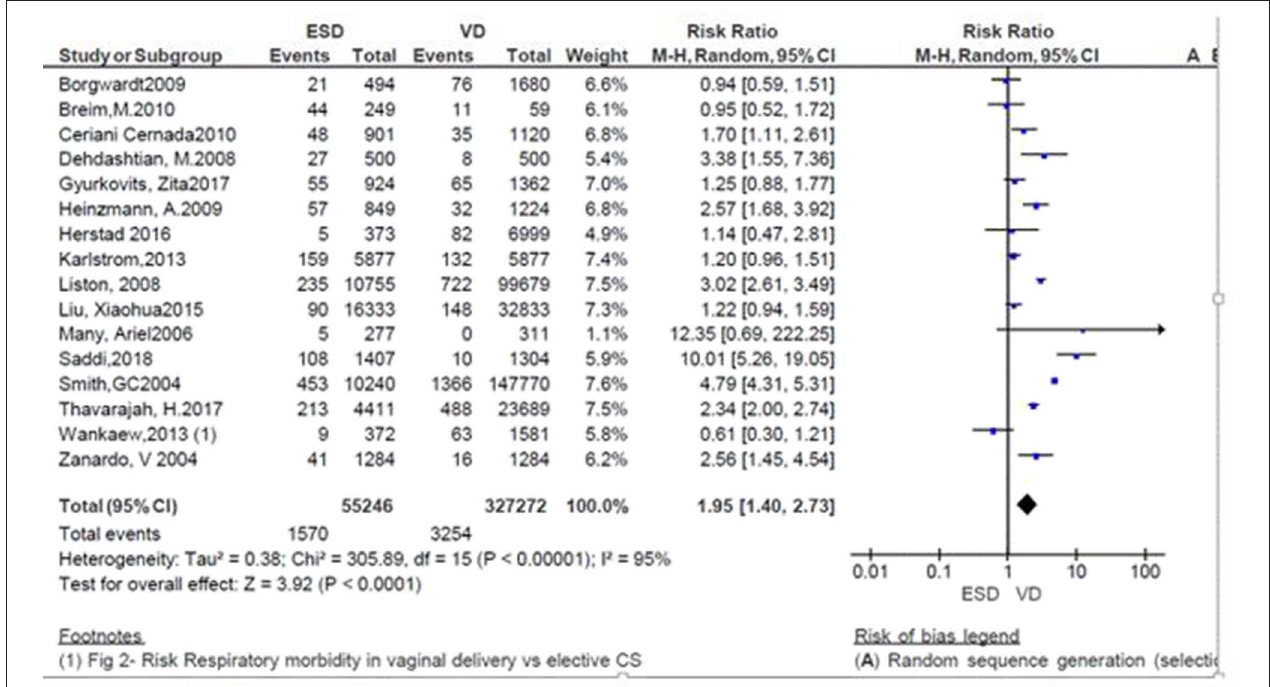
FIGURE 2 | Risk of neonatal respiratory morbidity in spontaneous vaginal delivery vs. elective cesarean, 2019.